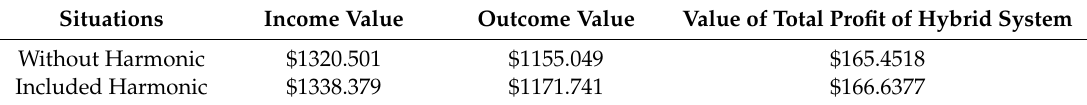
Table 3. Comparison of impacts of harmonic and non-harmonic loads in terms of cost.